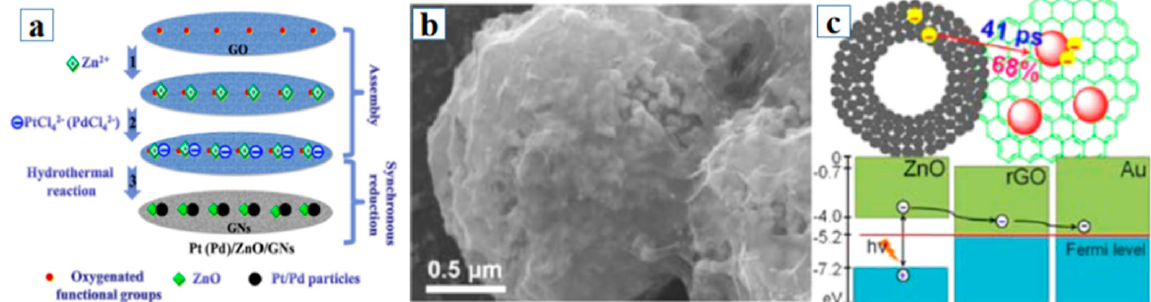
Figure 8. ( a ) Synthesis route for the Pt/ZnO/graphene nanosheet (GN) and Pd/ZnO/GNs composites; ( b ) SEM image of structure of ZnO–rGO hollow microspheres with Au nanoparticles; ( c ) energy band and structural principle of the ZnO–rGO hollow microsphere composite with Au nano- particles.